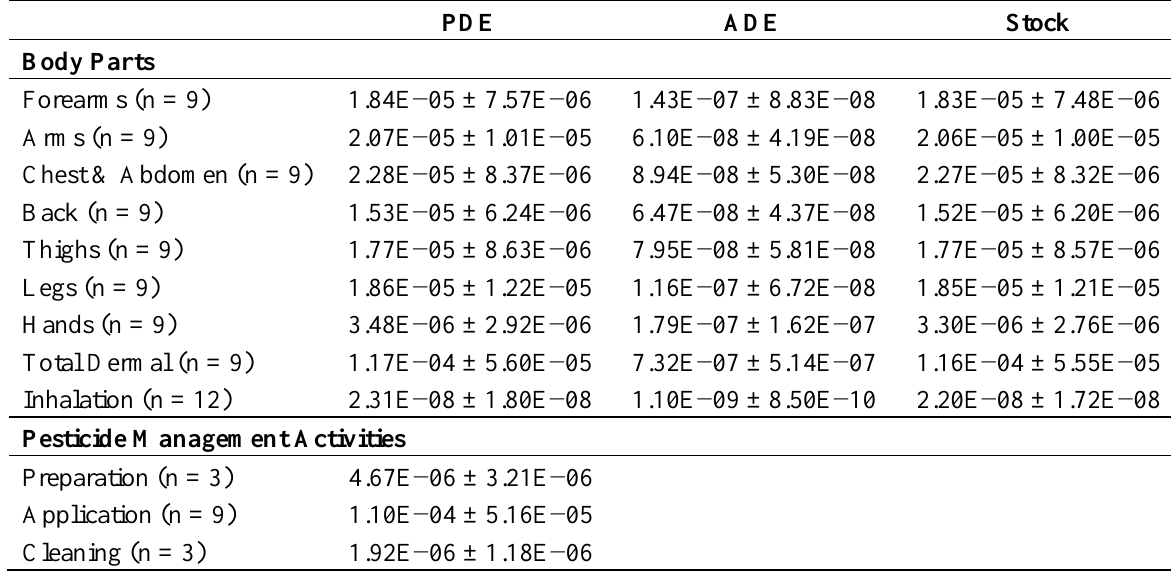
Table A1. Transfer coefficients used for the pesticide flow analysis model according to the field measurements of the tracer